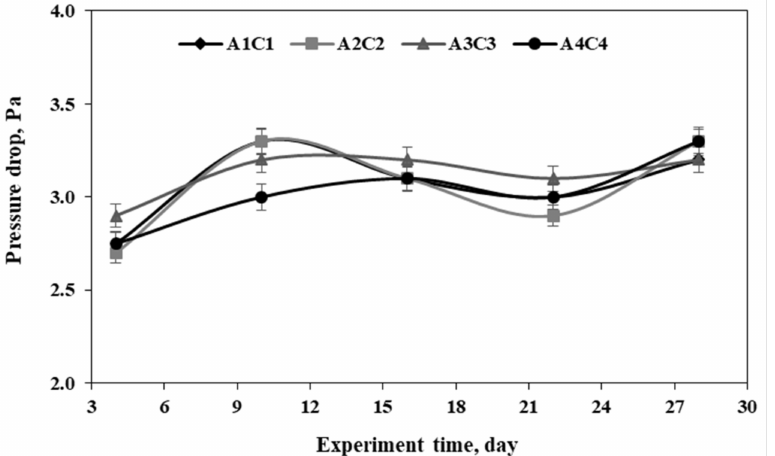
Figure 7. The pressure drop (Pa) across the biofilter packing material (between the points A1 and C1, A2 and C2, A3 and C3, and A4 and C4) composed of WPP and